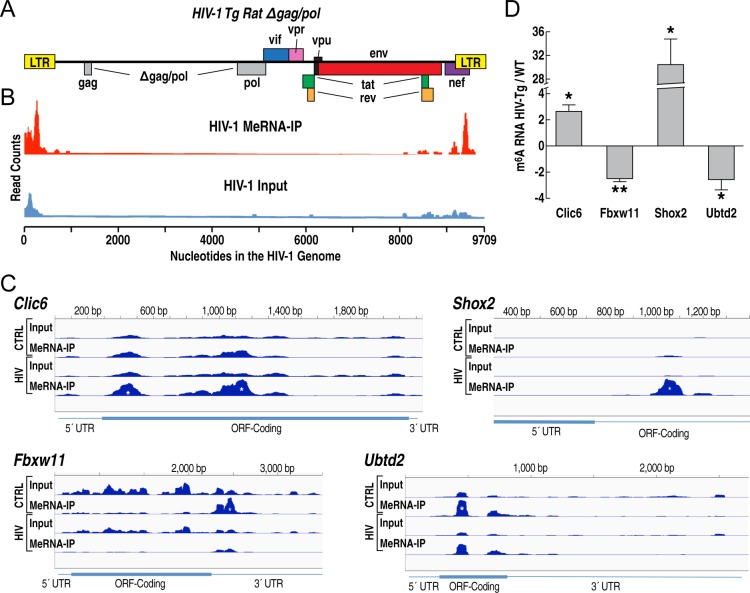
Pattern of m6A methylation in HIV and host transcripts of HIV Tg rats.A) Outline of HIV genome organization and gag/pol deletion in HIV Tg rats. B) m6A methylation in HIV RNA from HIV Tg rats (HIV-1 MeRNA-IP) is enriched in transcripts corresponding to the 5’ and 3’ of the virus with a similar overall distribution as observed in HIV transcripts in vitro [42–44]; signal obtained from RNA-Seq of input RNA from the hippocampus of HIV Tg rats (HIV-1 Input). C) Distribution of m6A methylation in representative host genes with significant differential m6A methylation (*significantly differentially methylated peaks). D) PCR validation of significantly differentially methylated intervals in the genes in D (*p<0.05, *p<0.01 by t test).